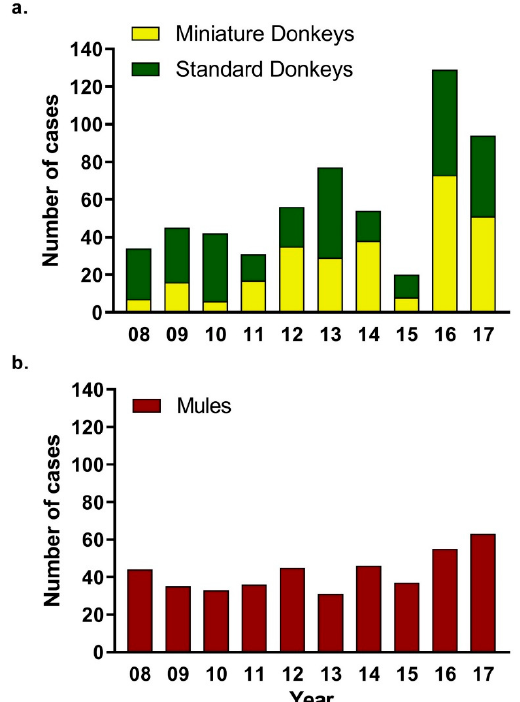
Figure 2. Distribution of the Donkey and Mule Visits for Each Year, from 2008 to 2017. The yearly distribution of the caseload for: ( a ) donkeys, including standard donkeys (green), miniature donkeys (yellow), and ( b ) mules (red).